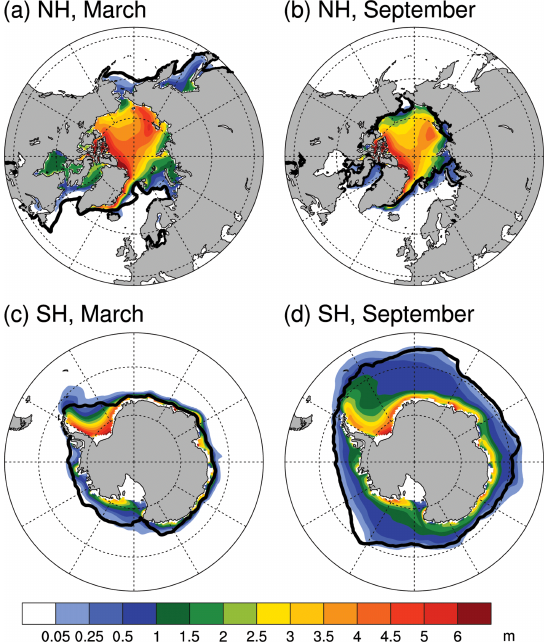
Fig. 11. Mean sea-ice thickness (m) over years 1976–2005 of NorESM Historical1 experiment Fig. 11. Mean sea ice thickness (m) over years 1976–2005 of the for both hemispheres and for (a, c) March and (b, d) September. For these panels, the solid NorESM Historical1 experiment for both hemispheres and for (a, black line shows the 15% monthly sea-ice concentration from the OSI SAF reprocessed dataset c) March and (b, d) September. For these panels, the solid black (EUMETSAT, 2011). line shows the 15% monthly sea ice concentration from the OSI SAF reprocessed data set (EUMETSAT,